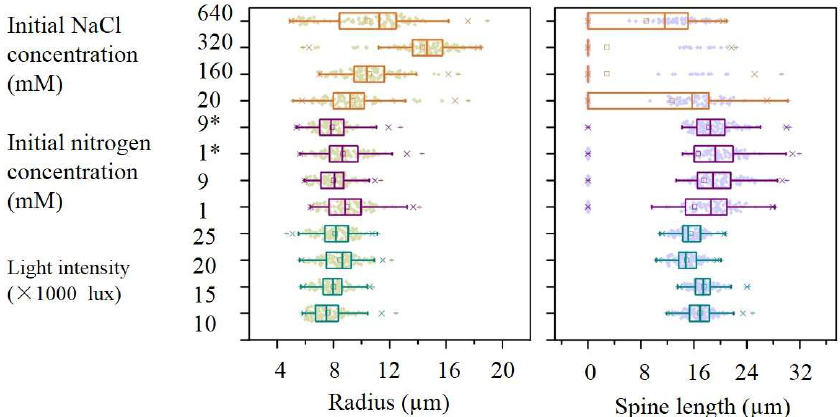
Figure 2. Cell radiuses and spine lengths of Golenkinia SDEC-16 were exposed to different culture conditions. In the initial nitrogen concentration group, 1 and 9 represent 1 mM and 9 mM initial nitrogen concentrations under the 10,000 lux; 1* and 9* represent 1 mM and 9 mM initial nitrogen concentrations under the 25,000 lux.